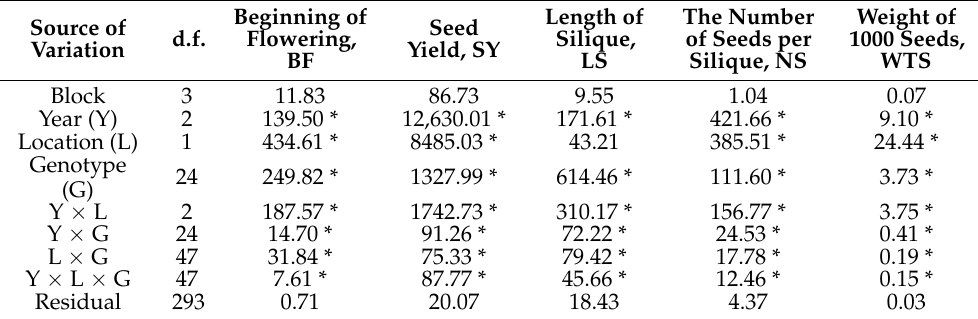
Table 5. Mean squares from three-way analysis of variance for five observed traits of winter oilseed rape.